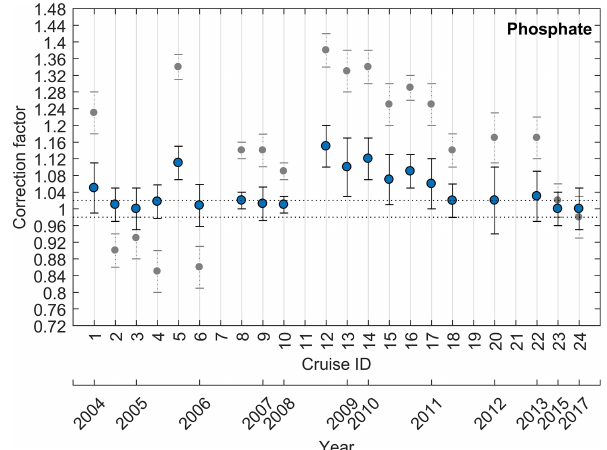
Figure 5. Results of the crossover analysis for nitrate, before (grey) and after (blue) adjustment. Error bars indicate the standard devia- tion of the absolute weighted offset. The dashed lines indicate the 2% accuracy limit for an adjustment to be recommended.